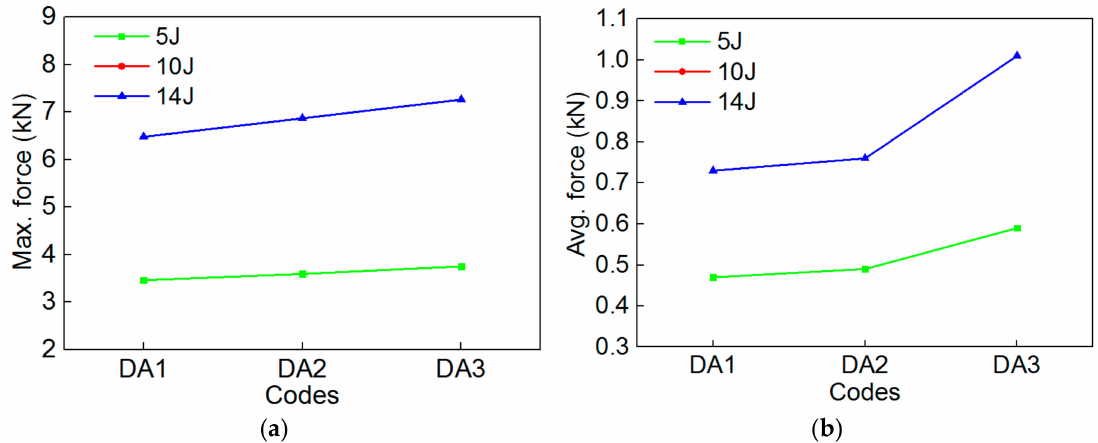
Figure 14. The maximum contact force and average contact force value of the specimen of DA1/DA2/DA3 under the two impact energies: ( a ) Max. force; ( b ) Avg. force.